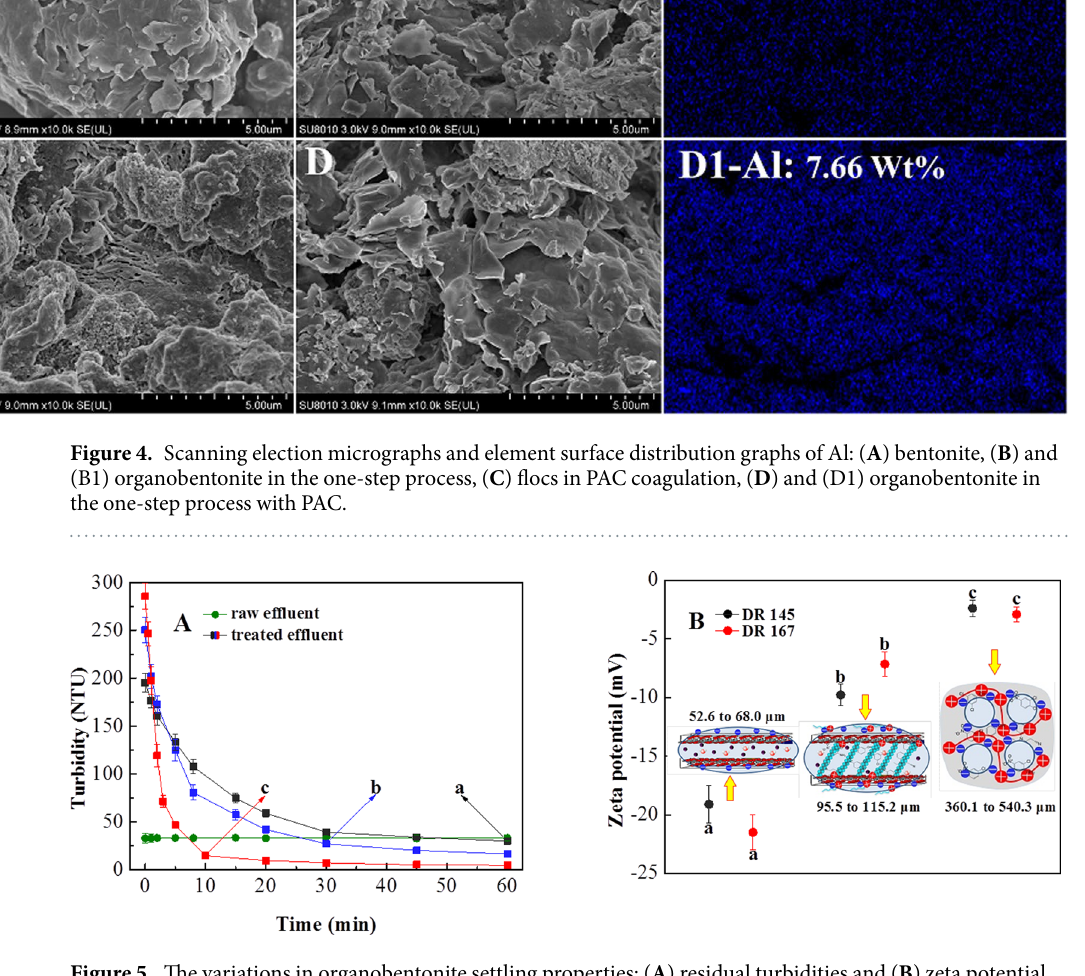
Figure 5. The variations in organobentonite settling properties: ( A ) residual turbidities and ( B ) zeta potential of (a) bentonite suspended effluent, organobentonite suspended effluent in (b) the one-step process and (c) the one-step process with PAC. Bentonite dose: 0.5 g L − 1 , CTMAB dose: 60% CEC, PAC dose: 0.5 g L − 1 . Error bars represent standard deviations ( n =